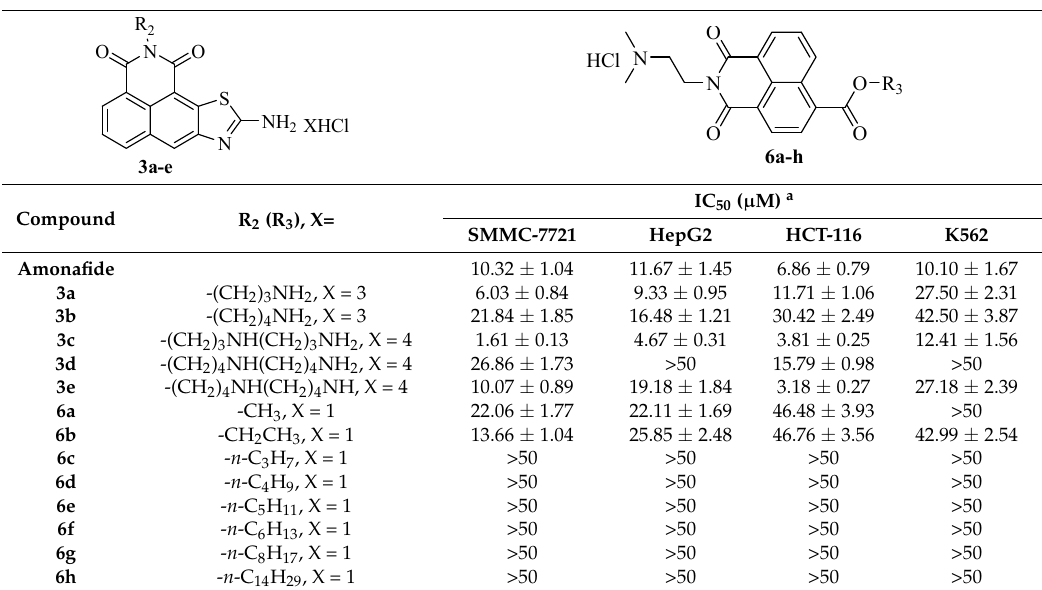
Table 1. Inhibitory results of target compounds against four cancer cell lines.